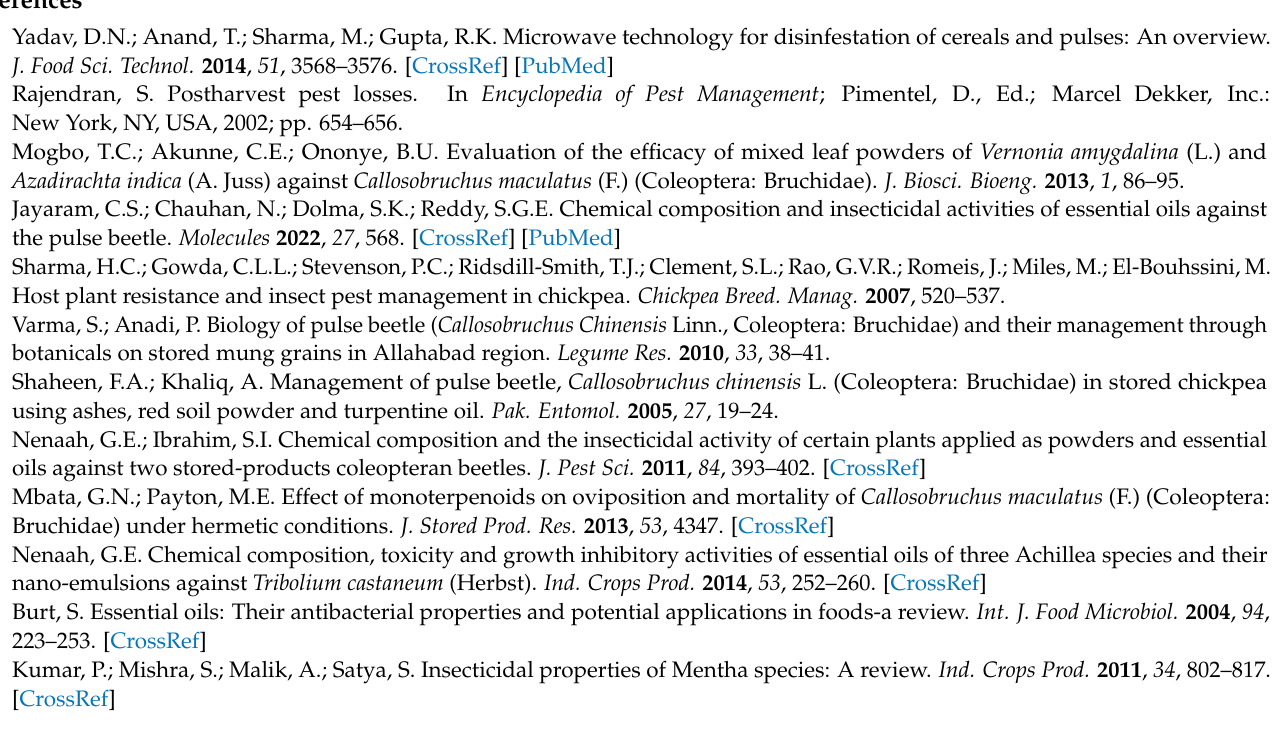
Table S4: Enzyme inhibition activity of A. maritima oil in C. chinensis and C. maculatus